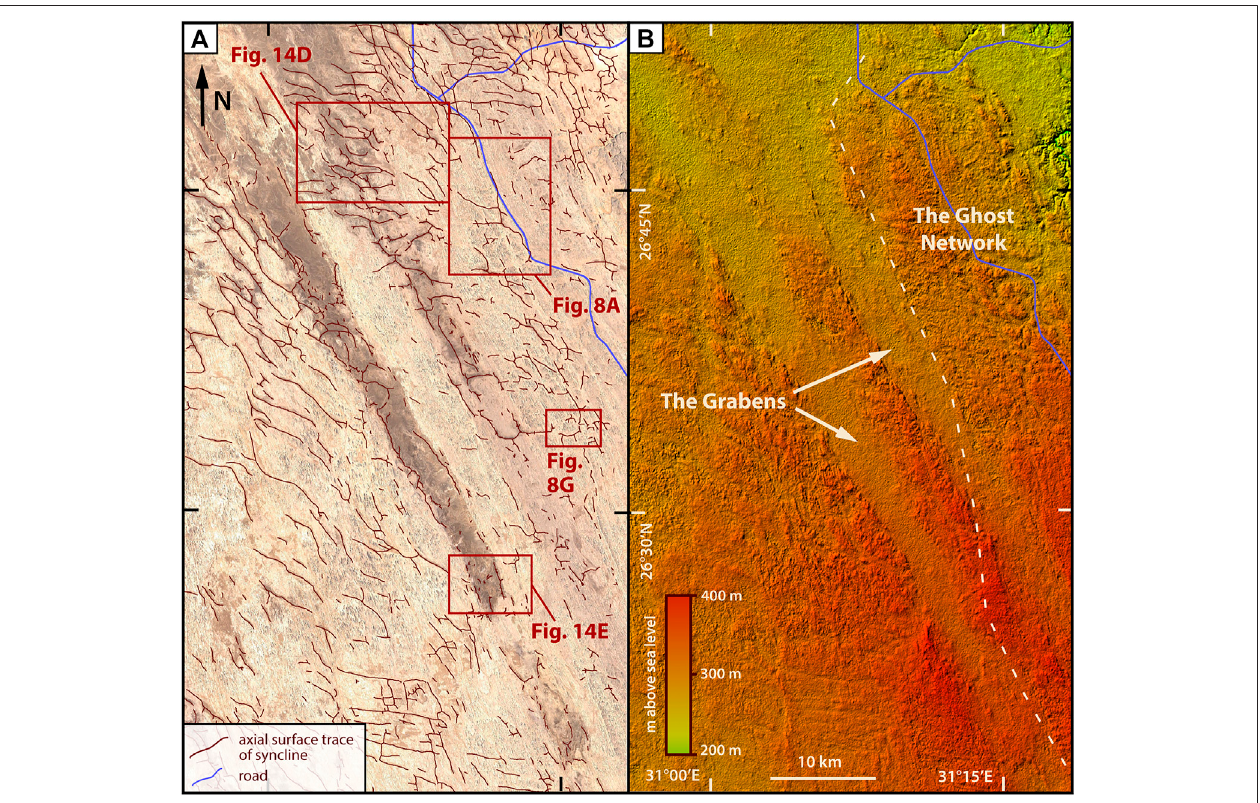
FIGURE7| Synclinenetworkandtopographyintheghostnetworkand thegrabens areas. (A) Axialsurfacetracesofallsynclines. (B) Colorizedshaded reliefmap ofsameareashownin7A.WhitearrowsshowtopographicexpressionofgrabensrelatedtocrustalextensioninEgyptduringinitiationofRedSearifting.Satelliteimagery source: Google Earth. Elevation model data source: Shuttle Radar Topography Mission (SRTM) digital elevation data. Coordinates for Google Earth image: A) 26.593547,